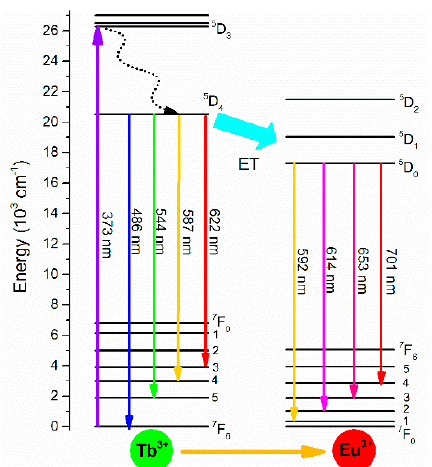
Figure 5. Schematic level diagram of Tb 3+ and Eu 3+ and the energy transfer mechanism.